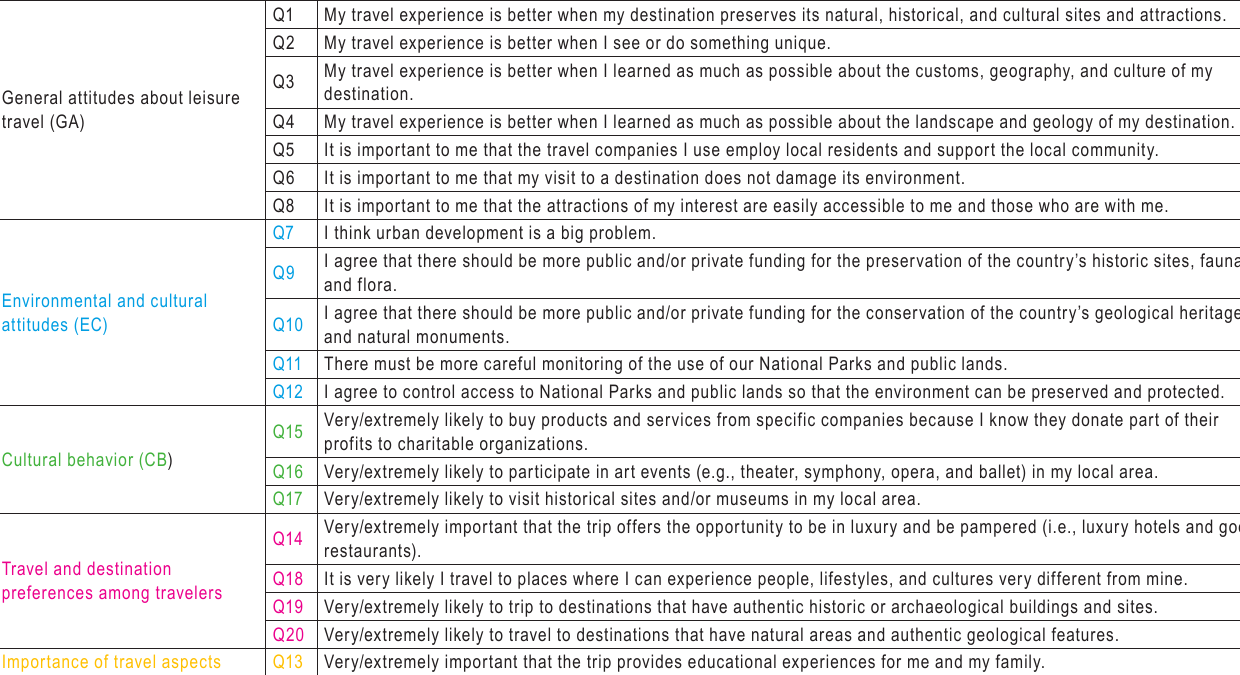
TABLE 1. Questions corresponding to each dimension for the definition of the geotourist profile.